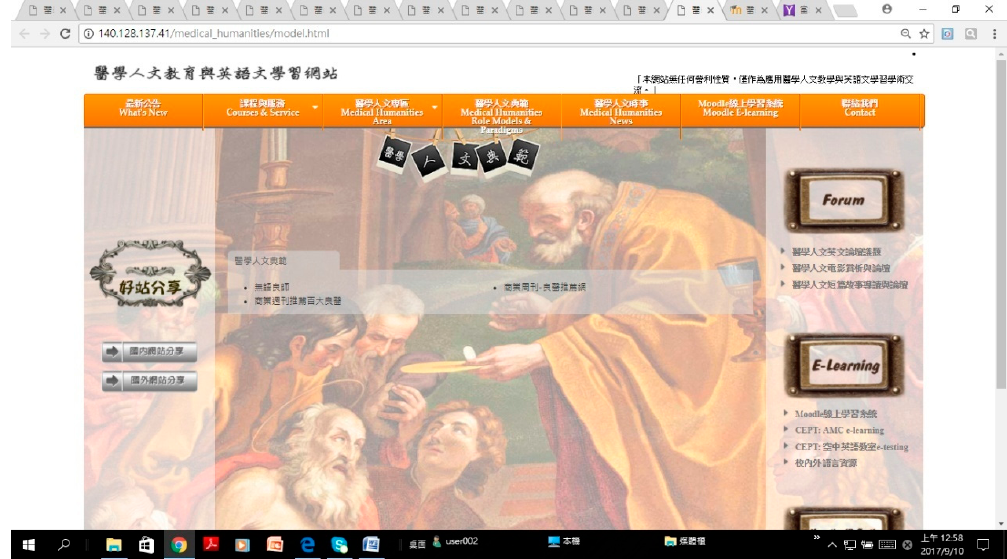
Figure 1. E-learning learning website for discussion forum.